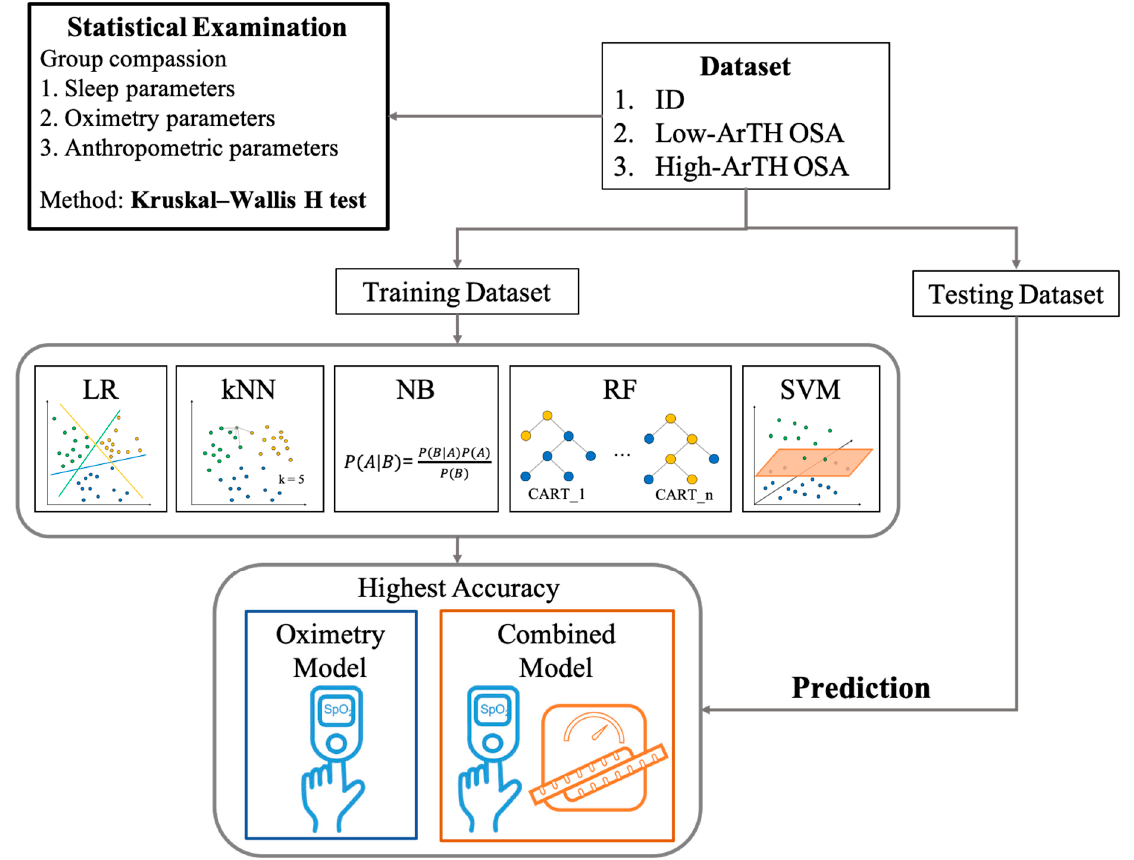
Figure 2. Schematic workflow. All derived data were first subjected to mean comparison for the three disease groups. Next, all data were divided into training and testing datasets. Five matching learning approaches were employed in this study, namely, a logistic regression (LR) model, k-nearest neighbors (kNN), naive Bayes (NB), random forest (RF), and support vector machine (SVM). Two types of models were established by using these five approaches, including the oximetry model, which was only trained using oximetry parameters, and combined models, which were trained by both oximetry and anthropometric parameters. The trained model with the highest accuracy in the training outcomes for both model types was used to predict the testing dataset. Abbreviations: ID: insomnia disorder; ArTH: respiratory arousal threshold; OSA: obstructive sleep